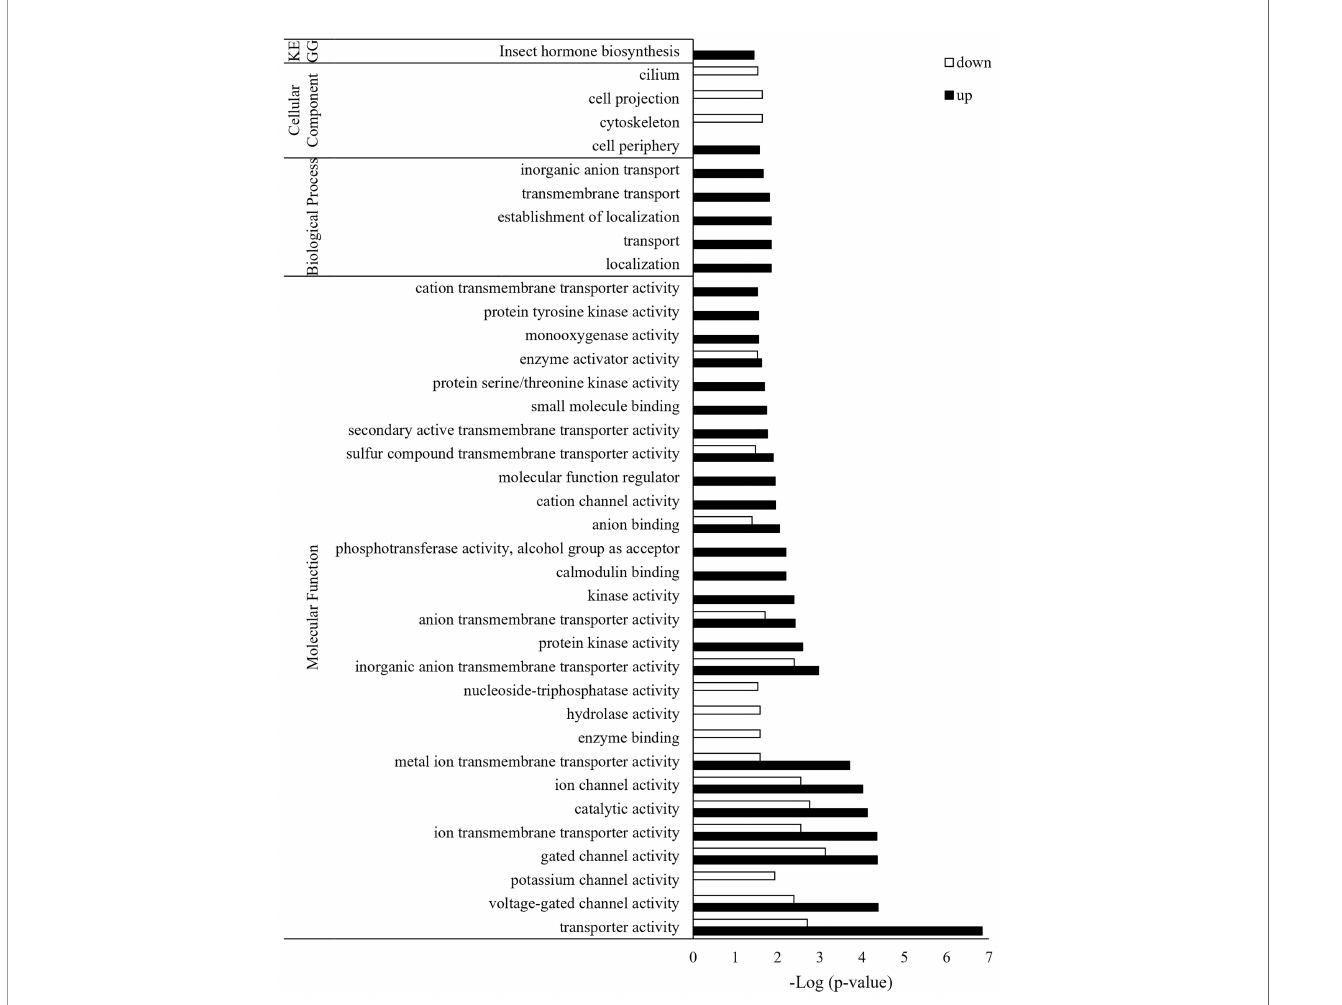
FIGURE 4 | GO enrichment analysis of JEF-544-infected aphid genes. Enrichment analysis was performed to con fi rm signi fi cant functions among DEGs of infected aphids. FDR <0.05 was used as the signi fi cance threshold, and Acyrthosiphon pisum was used as the